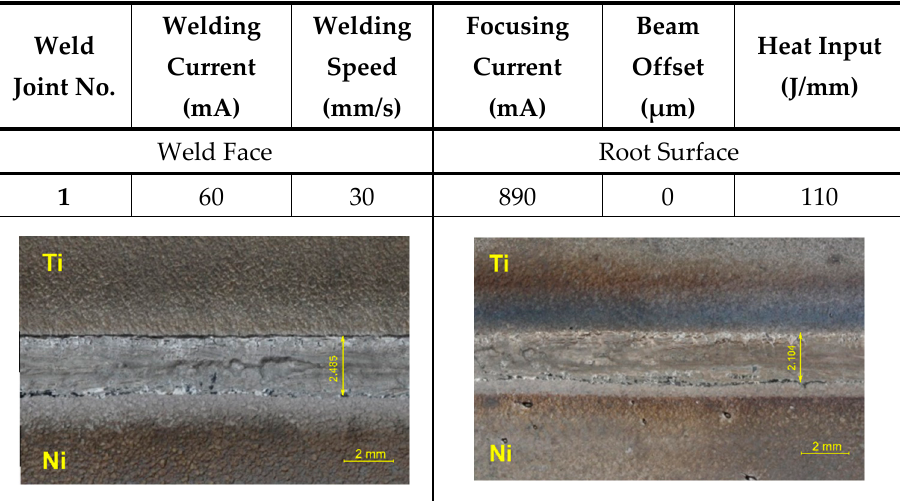
Figure 3. The tensile test specimens’ schematic ( a ), and fractured test specimens after tensile testing ( b ).